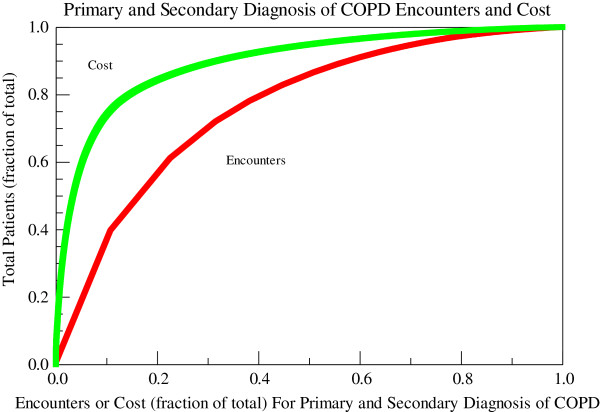
Encounters and costs for primary and secondary diagnosis of COPD at the cincinnati VAMC in FY08. Costs are represented by the green line and encounters (outpatient visits, emergency department visits, and hospitalizations) by the red line. FY: fiscal year; COPD: chronic obstructive pulmonary disease.